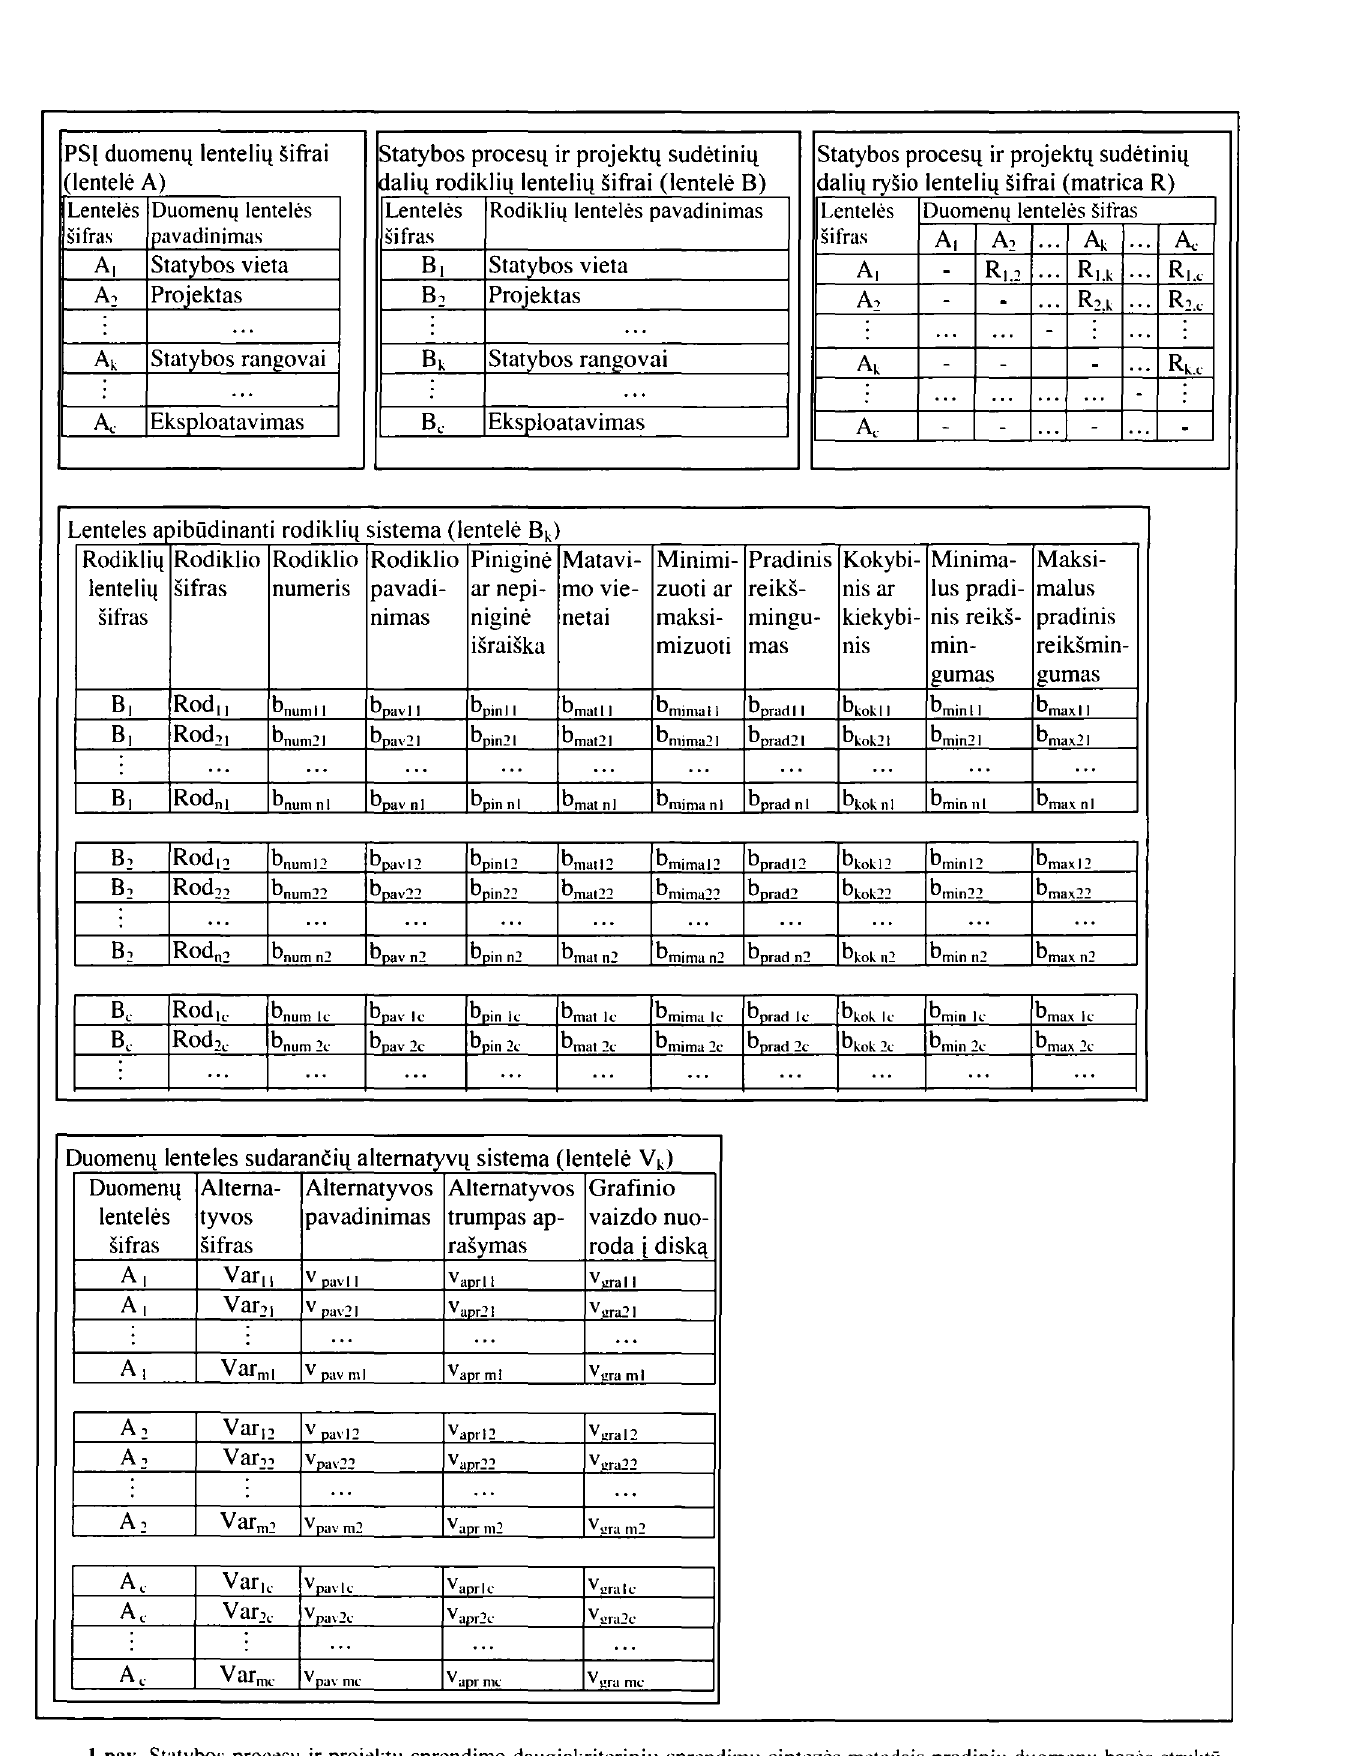
Fig 1. Primary database scheme for construction processes and project selection